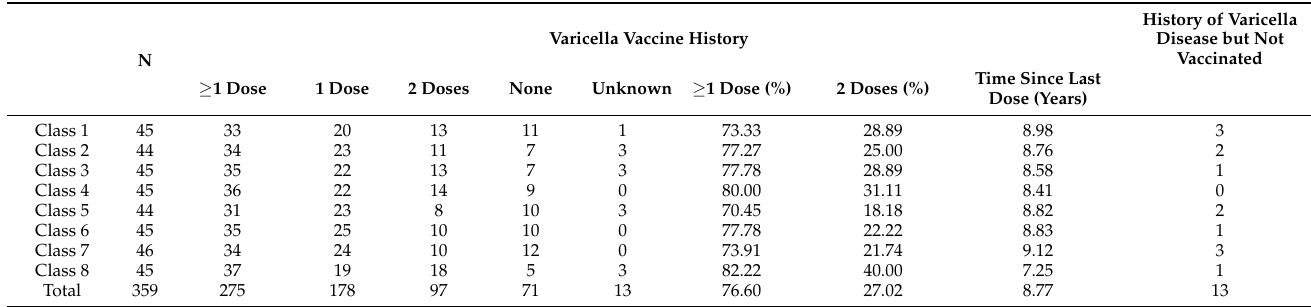
Table 2. Varicella vaccine coverage by class on the affected floor.